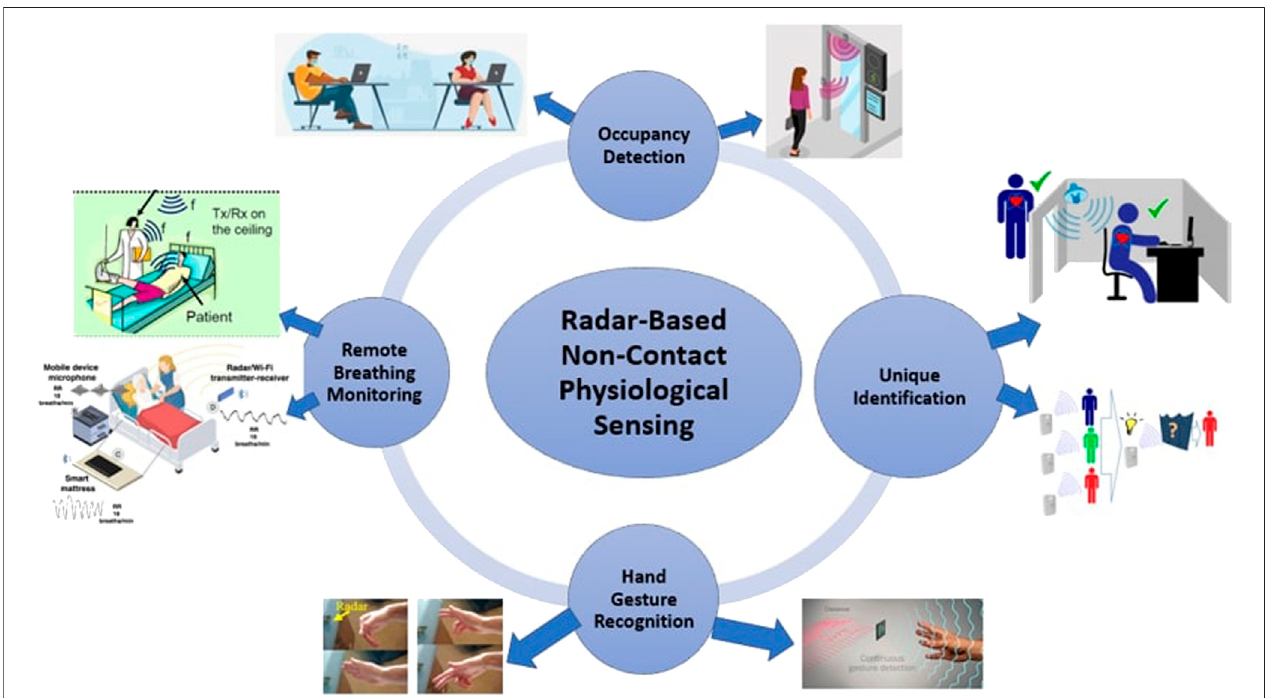
FIGURE 3 | Potential application areas of Radar-based physiological sensing technology for fi ghting the COVID-19 pandemic.